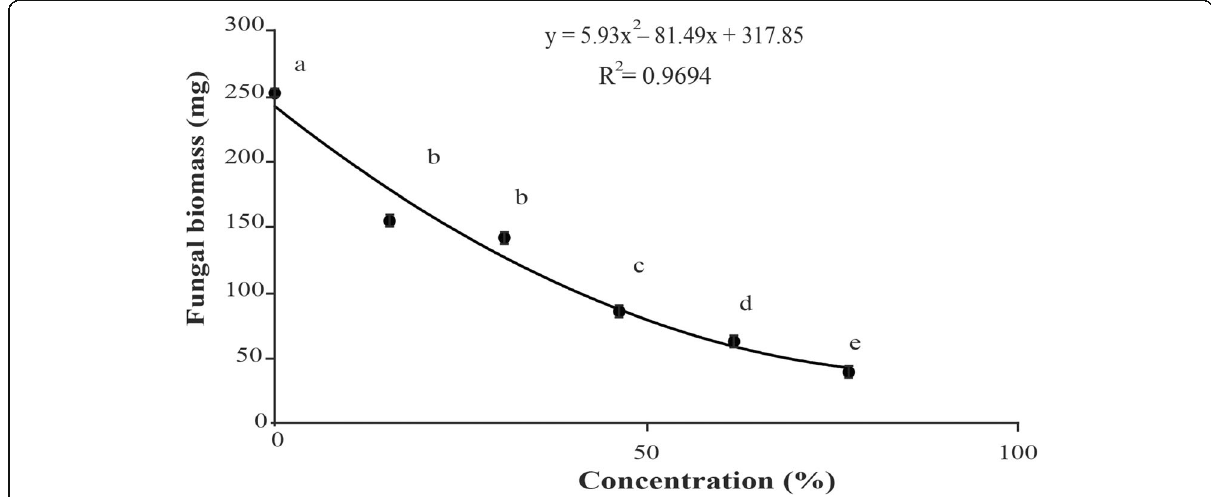
Fig. 3 The relationship between EI-15 culture filtrate concentrations and the biomass production of Alternaria alternata . Vertical bars show standard errors of the means of three replicates. Values with different letters show the significant difference as determined by Duncan ’ s multiple range (DMR)